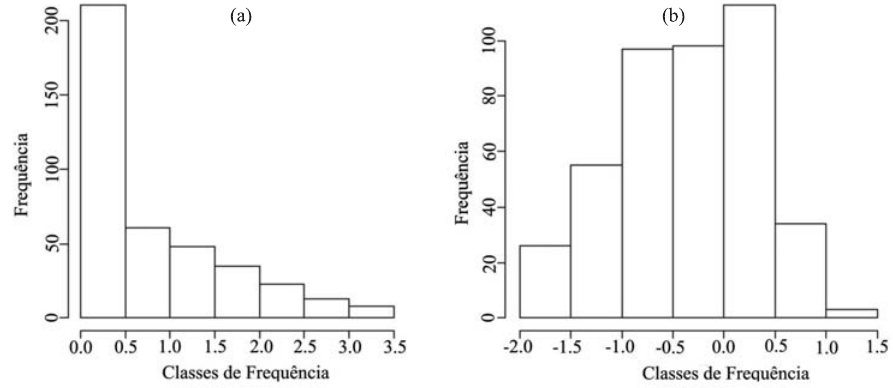
Figura 6. Histogramas de frequência de dados sem (a) e com transformação logarítmica